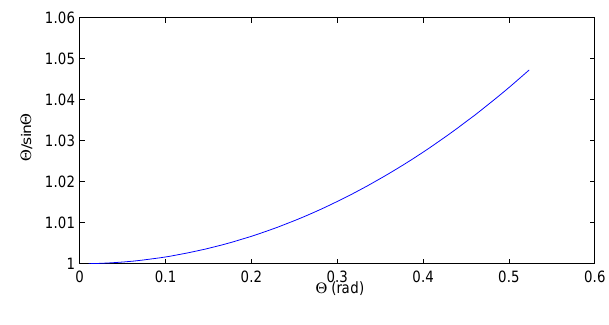
Figure 2. Θ / sin Θ